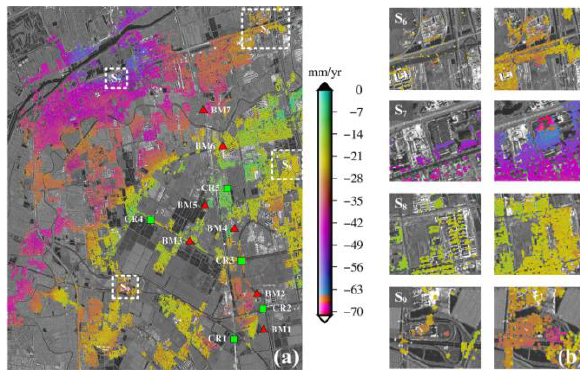
Figure 5. (a) distribution of subsidence rates at all the valid pixels, and (b) comparisons between subsidence rates derived from Group 0 and Groups 0–9 in four areas labeled by S6, S7, S8 and S9, respectively.